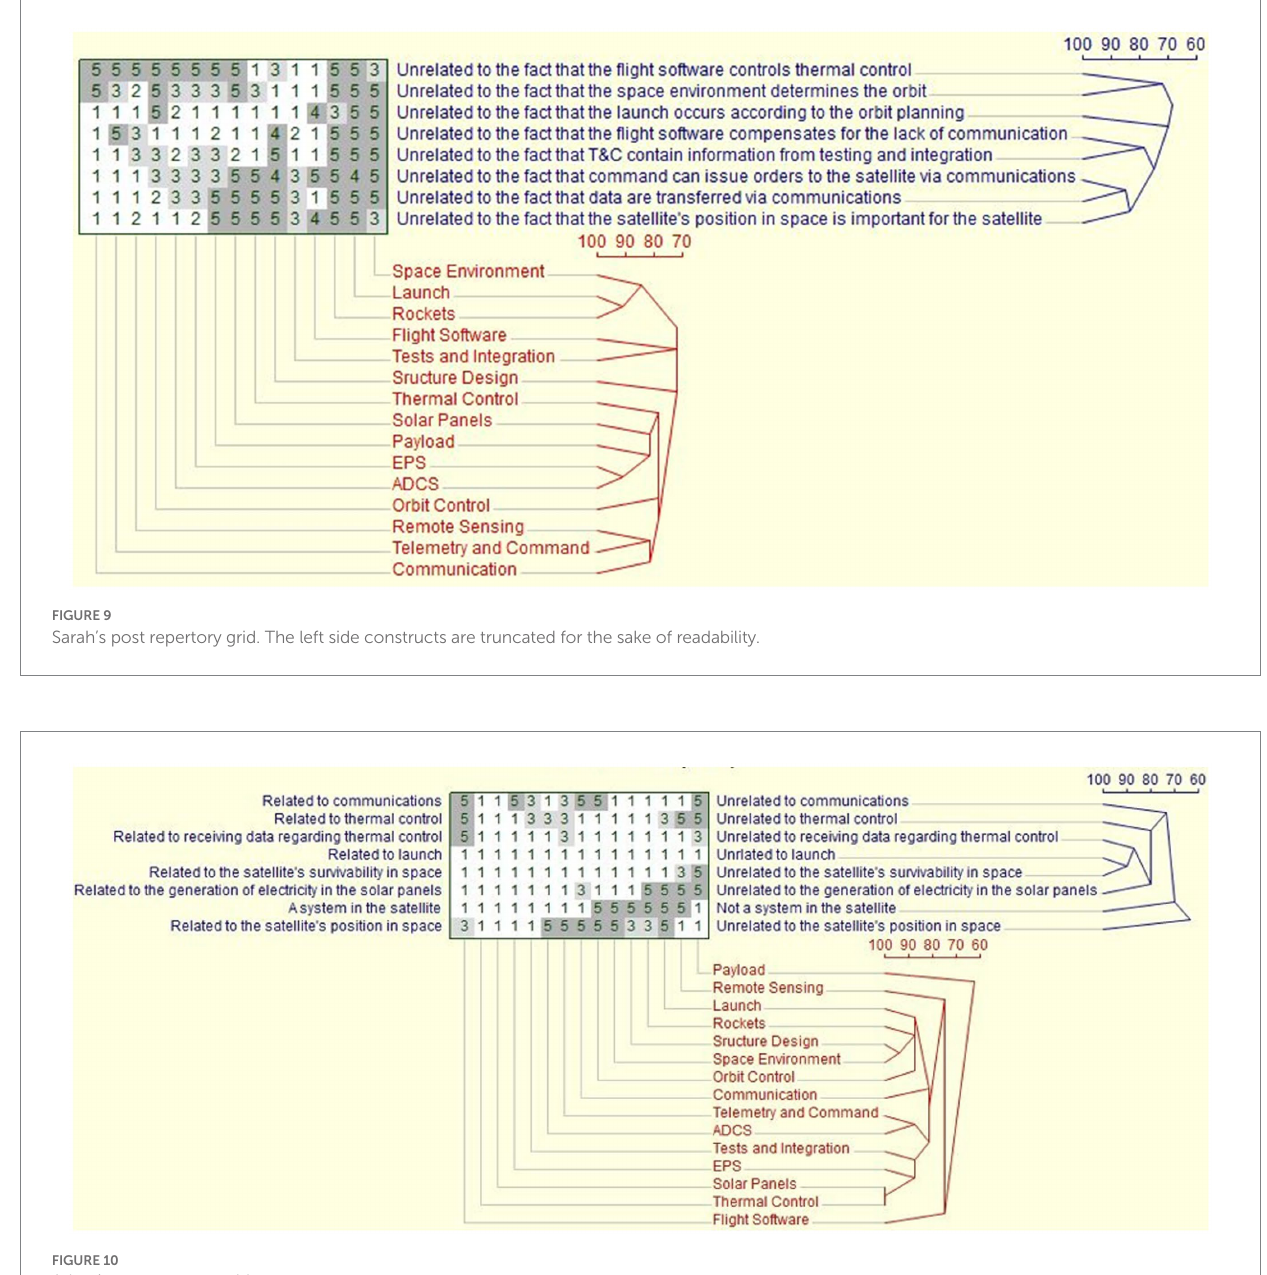
FIGURE 10 Adam’s pre repertory